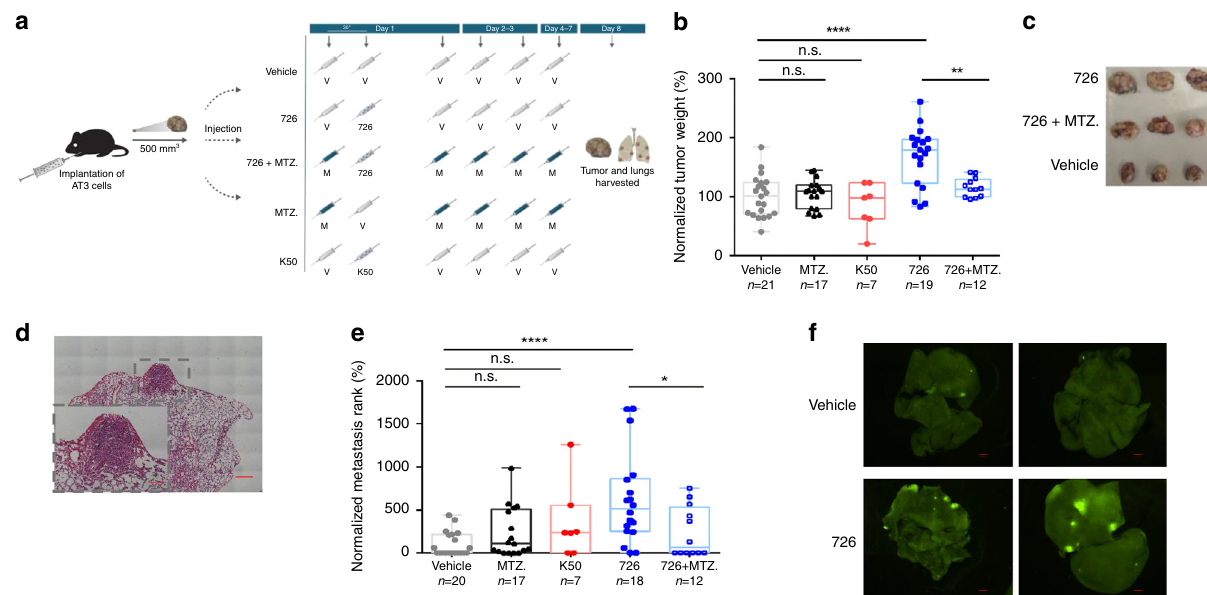
Fig. 5 F. nucleatum ATCC 23726 accelerates tumor growth and progression of lung metastasis. a Experimental scheme: AT3 breast cancer cell line was injected to the mammary fat pad of 6 – 7-week-old C57BL/6 mice. When tumor size reached 500 mm 3 , PBS vehicle (V), 5 × 10 7 F. nucleatum ATCC 23726 only (726), 5 × 10 7 F. nucleatum ATCC 23726 with metronidazole (726 + MTZ.), metronidazole only (MTZ.), or 5 × 10 7 Fap2-de fi cient F. nucleatum K50 were injected into the tail vein. On days 2 – 3 post inoculation, mice were injected twice a day with metronidazole (M) or with PBS vehicle (V). On days 4 – 7 post inoculation, mice were injected once a day with metronidazole or with PBS. Eight days after inoculation, mice were sacri fi ced, and tumor and lungs harvested. Breast cancer tissues were weighed, and lung metastases were counted. b Tumor weights normalized as the percentage compared with the average tumor weight in the PBS group (vehicle control) in each experiment (set as 100% tumor weight). Each symbol represents one mouse. Presented results are of three independent experiments. **** p = 3.48 × 10 − 5 , ** p = 0.002. Holm ’ s correction, one-tailed Mann – Whitney. Vehicle n = 21, MTZ. n = 17, K50 n = 7, 726 n = 19, 726 + MTZ. n = 12. c Representative tumors post-harvest. d Representative image of lung metastases. Scale bar, 500 µ m in the large image, 250 µ m in the indicated inset. e Lung metastasis rank [number of metastases per lung area (pixel 2 )] calculated as percentage compared with the average metastasis rank in the vehicle control group of each experiment (set as 100% metastasis rank). Each symbol represents one mouse. Presented results are of three independent experiments. **** p = 4.08 × 10 − 5 , * p = 0.0177, n.s.: non-signi fi cant, Holm ’ s correction, one-tailed Mann – Whitney. Vehicle n = 20, MTZ. n = 17, K50 n = 7, 726 n = 18, 726 + met n = 12. f Images taken by fl uorescence binocular of lung metastases in four mice implanted with GFP-expressing AT3 cells as described above. Two tumor-bearing mice were inoculated with F. nucleatum and two were treated by PBS vehicle. Scale bar, 1000 µ m. Source data are provided as a Source data fi